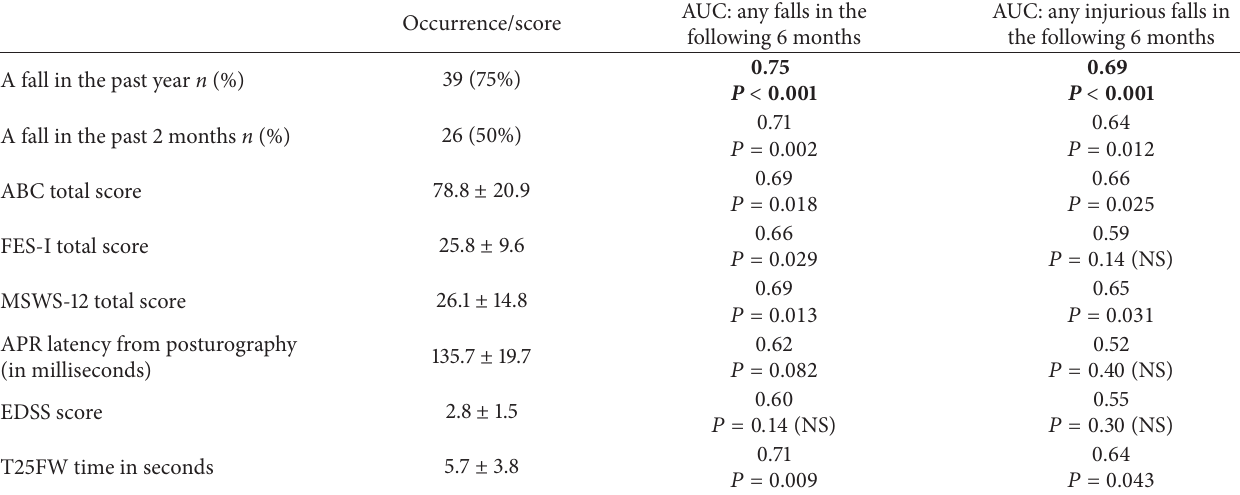
Table 3: Average sensitivity of baseline variables for predicting falls and injurious falls in the following 6 months. AUC: any falls in the Occurrence/score